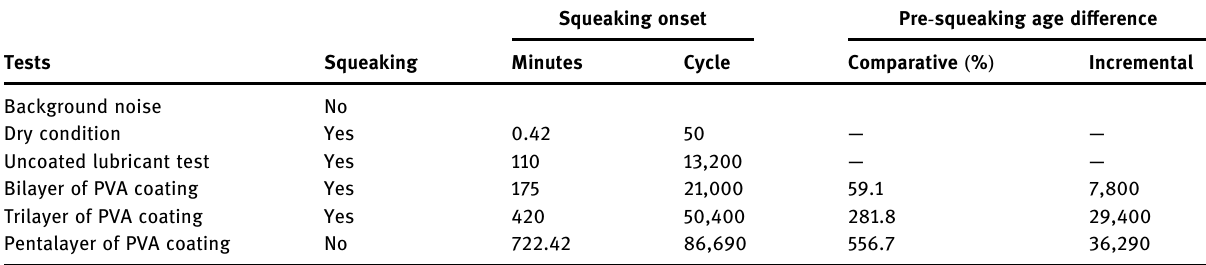
Table 1: Summary of the squeaking onset, incremental, and comparative pre - squeaking age di ff erence for all the tests performed Squeaking